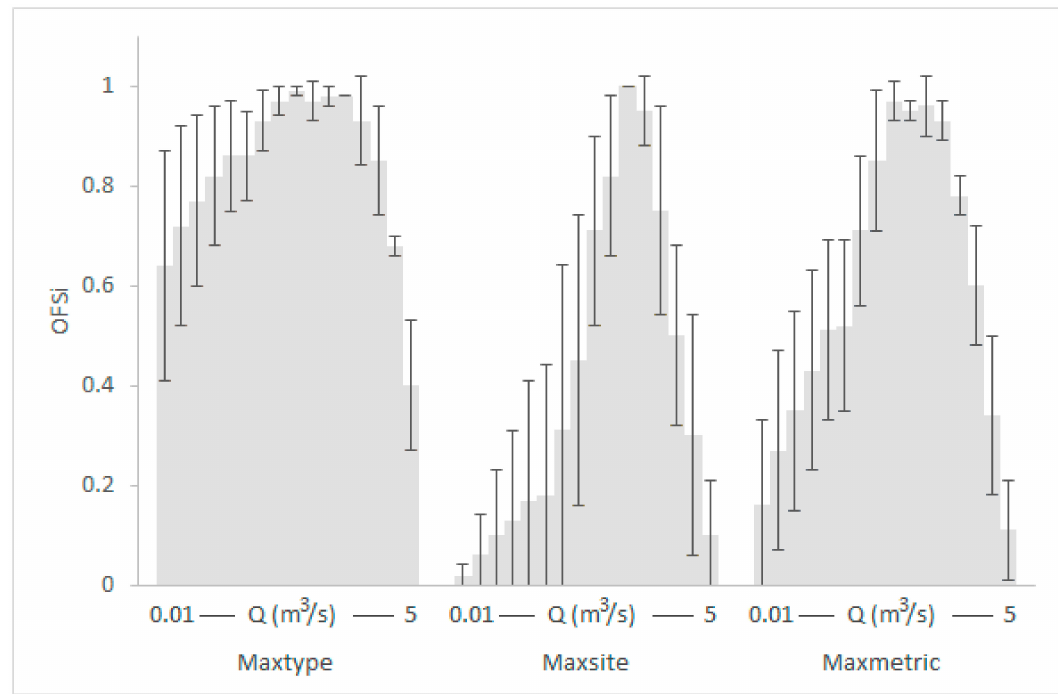
Figure 8. Graphical representation of the typological OFS means (gray shaded) and standard deviations within the various κ -normalization alternatives for the Oinoi reach. The OFS values of RM1-2 and RM4 types for each discharge (Q) have been